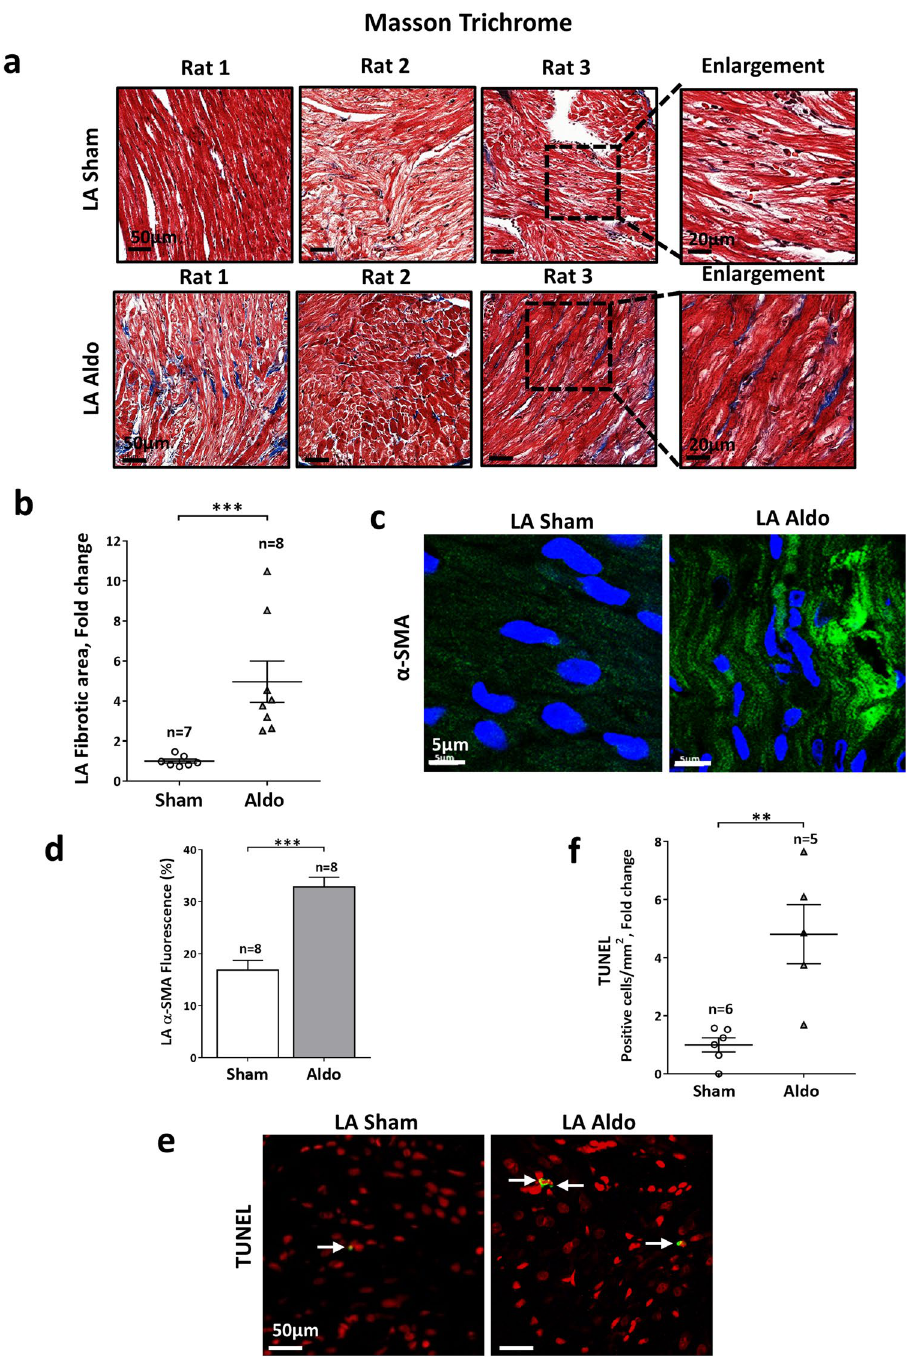
Figure 5. Atrial structural remodeling in rats exposed to excessive Aldo levels. ( a , b ) MT staining and its quantitative analysis of myocardial fibrosis in the LA of sham and Aldo rats. ( a ) Representative photomicrographs for each condition. Scale bars, 50 µm and enlargement of 20 µm. ( b ) Summarizing scatter plot of quantitative image processing analysis. Note increased LA fibrosis in Aldo rats. ( c , d ) IF staining of the expression of α-SMA in the atrial tissues of the sham and Aldo rats using IF staining. Two fields were analyzed from each rat. n represents the total number fields . ( c ) : Representative photomicrographs for each condition. Scale bars, 50 µm ( d ) Summarizing scatter plot of quantitative image processing analysis. As expected, increased expression of α-SMA was noted in the Aldo treated atria in accordance with the elevated fibrotic load. ( e , f ) TUNEL analysis, performed by counting the total number of TUNEL-positive cells in each LA section normalized to its surface area ( e ) Representative photomicrographs for each condition. Scale bars, 50 µm. ( f ): Summarizing dot plot of quantitative image processing analysis. Note increased apoptosis in the LA of Aldo rats. The number of rats in each group is indicated (n =